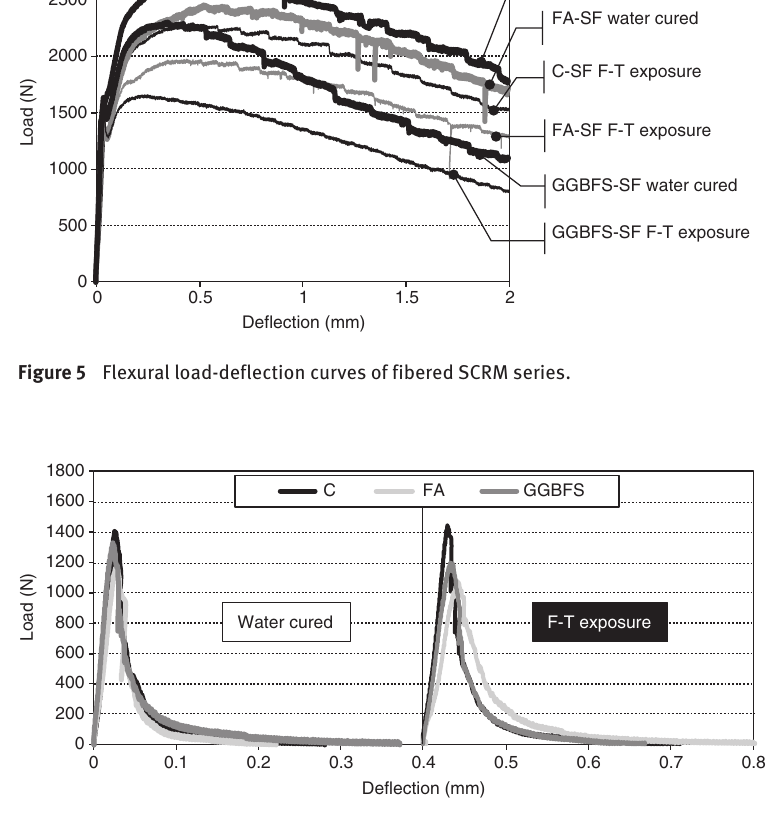
Figure 6 Flexural load-deflection curves of plain SCRM series that were water cured and exposed to F-T.